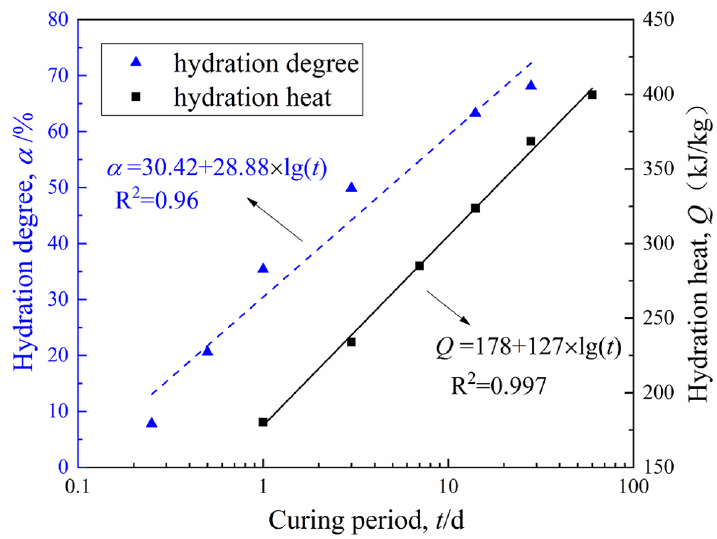
Figure 5. Relationship between CW mass and curing period.